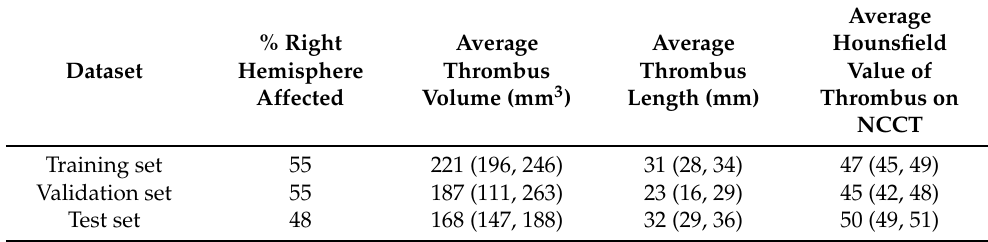
Table 1. Dataset characteristics. Numbers in the parenthesis show the 95% confidence